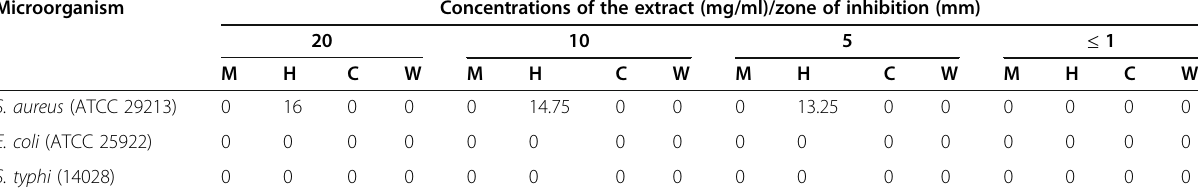
Table 4 Antibacterial activity of B. senegalensis on the test bacteria Microorganism Concentrations of the extract (mg/ml)/zone of inhibition (mm)